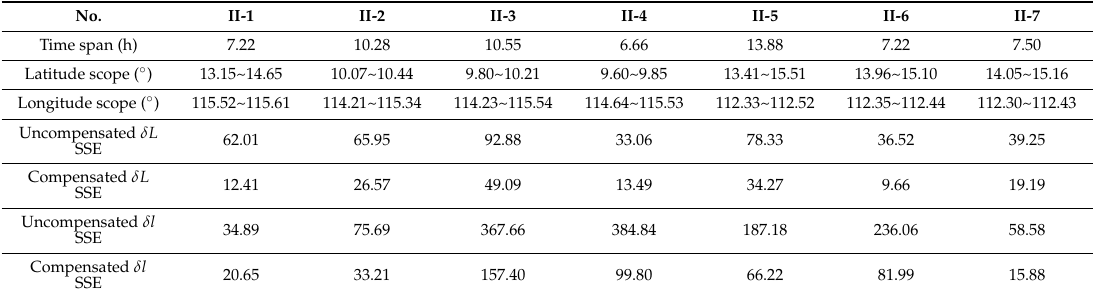
Table 1. SSEs of fittings of the normalized horizontal position errors before and after compensation.